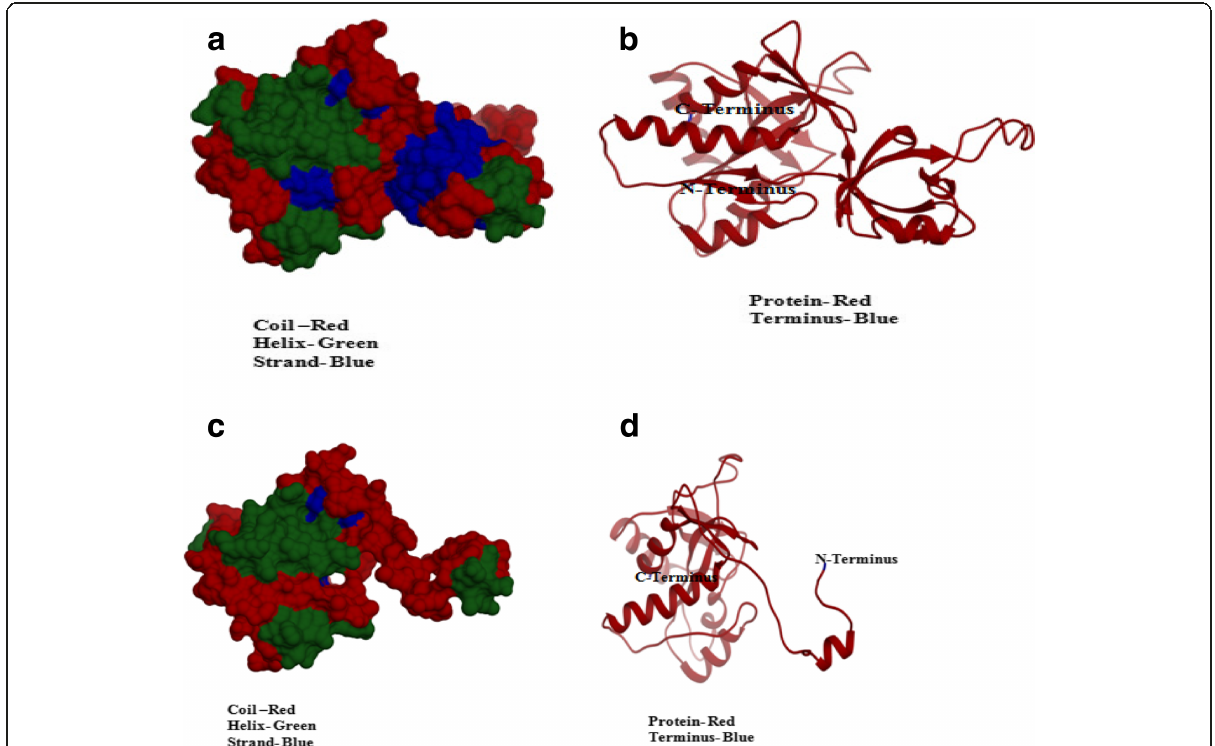
Fig. 5 The three-dimensional molecular structures of PW1 and PW2 endoglucanases generated by homology modeling. Surface models ( a , c ) and ribbon models ( b , d ) of PW1 and PW2 endoglucanases were generated using aminopeptidase/glucanase homolog of Bacillus subtilis strain168 (pdb_1VHE.A) as a template. Alpha helices are colored green, beta strands are in blue, and linkers are shown in